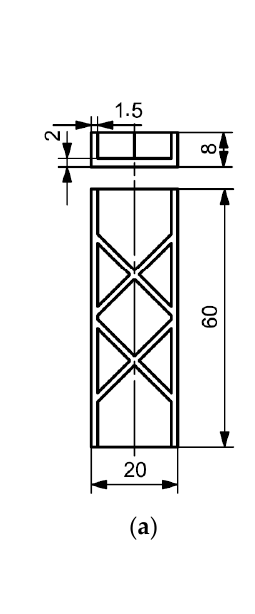
Figure 10. Experimental setup with lower and upper clamping and speckled specimen.